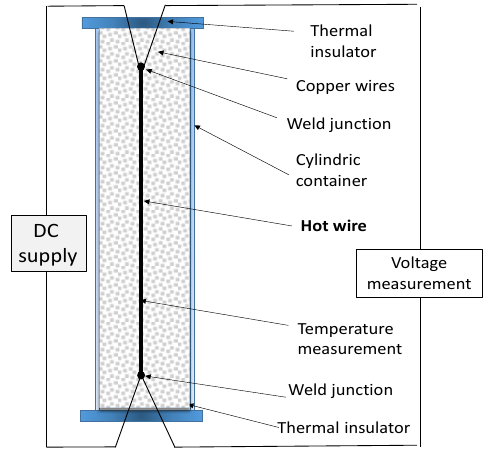
Figure 4. Schematic apparatus for hot wire tests (adapted from [56] with permission of Elsevier). Table 2. Phases, experimental parameters and literature sources for hot wire tests on C-PCMs.